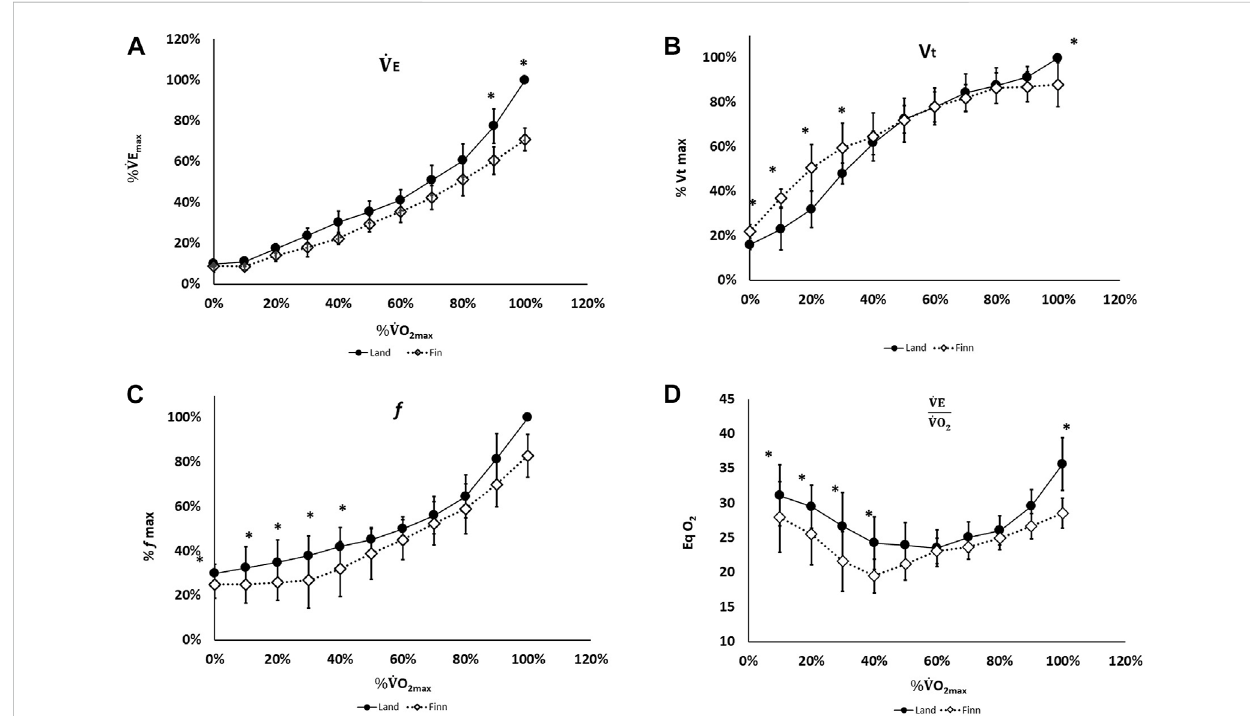
FIGURE 2 Changes to respiratory variables and heart rate (HR) expressed as a percentage relative to maximal oxygen consumption on land. Variables are expressed as a percentage of the maximum value recorded during the test. _ V E, pulmonary ventilation; f, breathing frequency; Vt, tidal volume. Filed symbols: incremental tests in land condition; open symbols: incremental tests in fi n condition. *the difference between the two conditions for the same metabolic load expressed as % _ V O 2max was signi fi